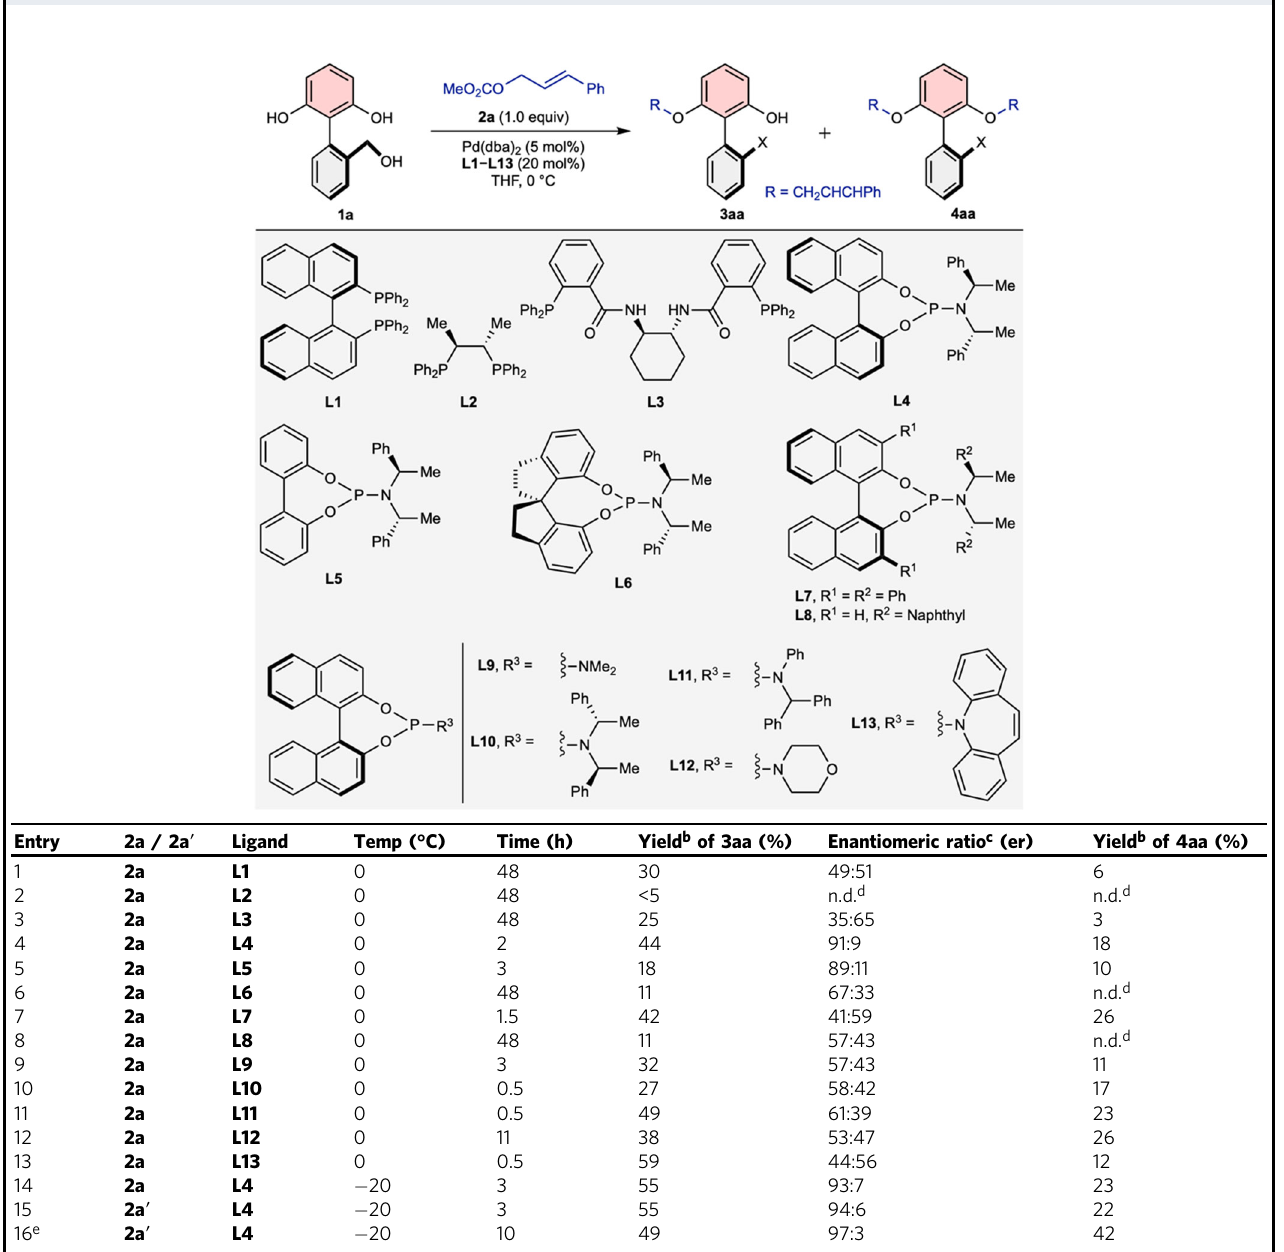
Table 1 Reaction optimizations a